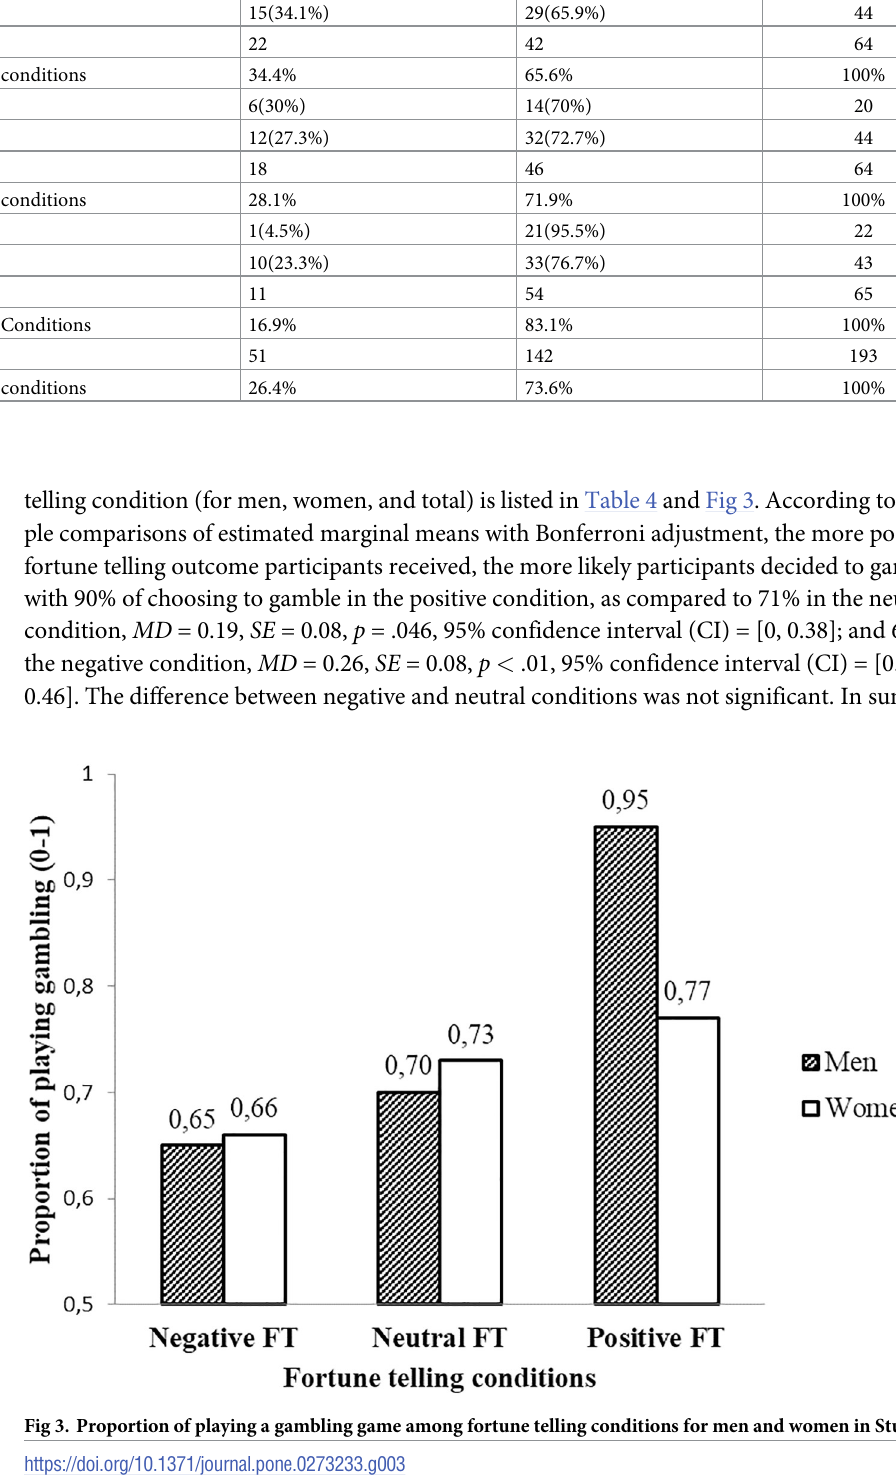
Decision-making (Count (%))